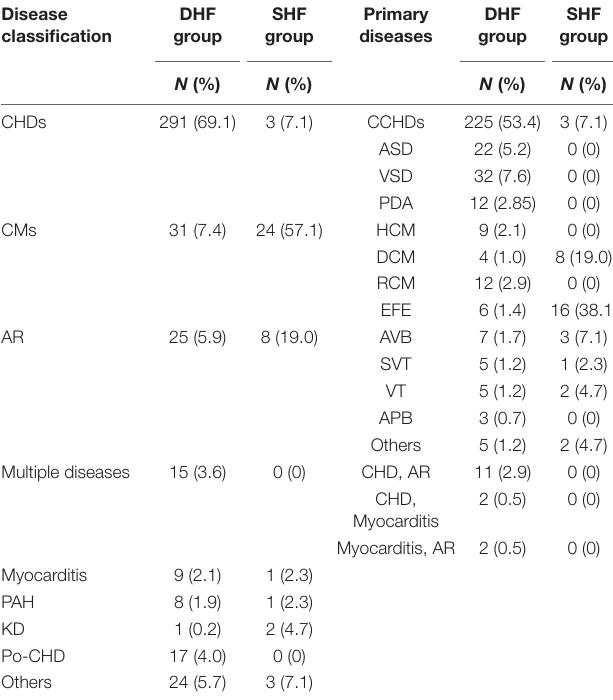
TABLE 2 | Primary diseases of pediatric DHF and SHF. Disease classification